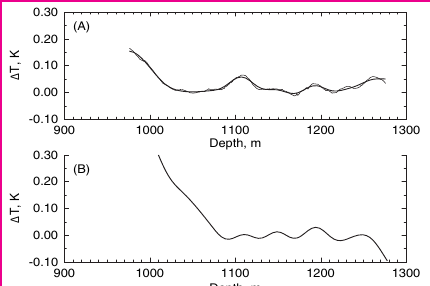
Figure 3. [A] Observed temperature anomaly in Hole A and [B] temperature anomaly predicted from the thermal conductivity measurement of core from Hole B. The depth of Hole B is shifted by 26 m, which is the difference between the 1111 m fault zone detected in Hole A and the 1137 m fault zone in Hole B. Thick lines shows the temperature anomalies that are low pass fil- tered with cutoff length of 40